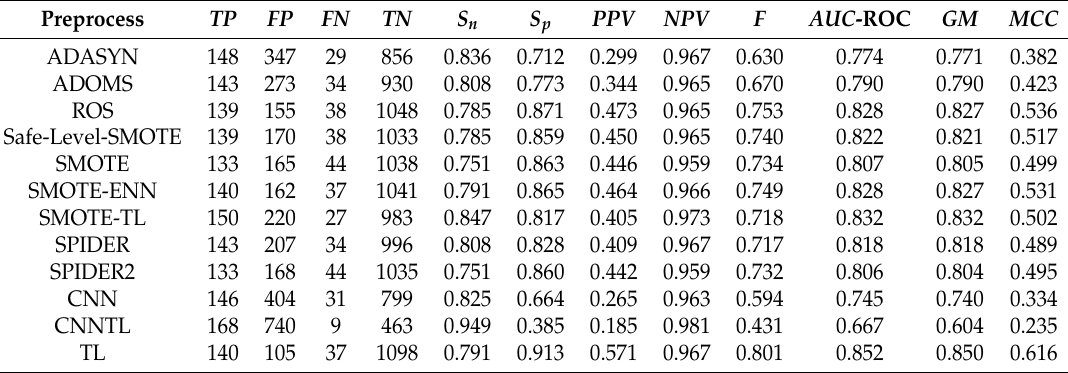
Table 3. Evaluation measures for each preprocessing, when Bagging is